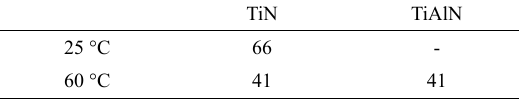
Table 4. Efficiency of the protective coatings in NaOH solution